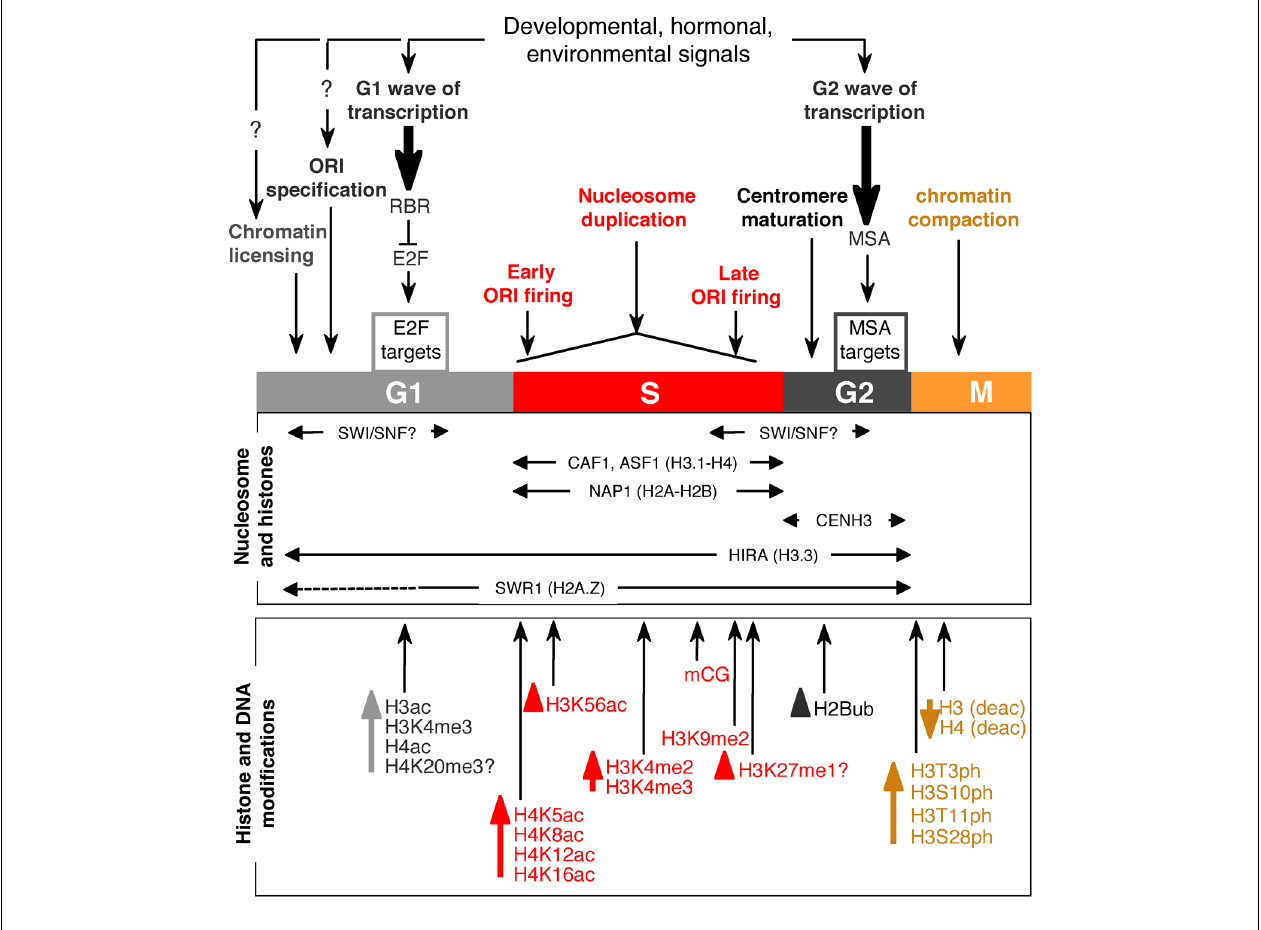
FIGURE 1 | Schematic view of chromatin processes intimately coordinated with cell cycle progression. Changes in chromatin accessibility, which in many cases depend on histone modifi- cations, histone exchange, and nucleosome reorganization, and